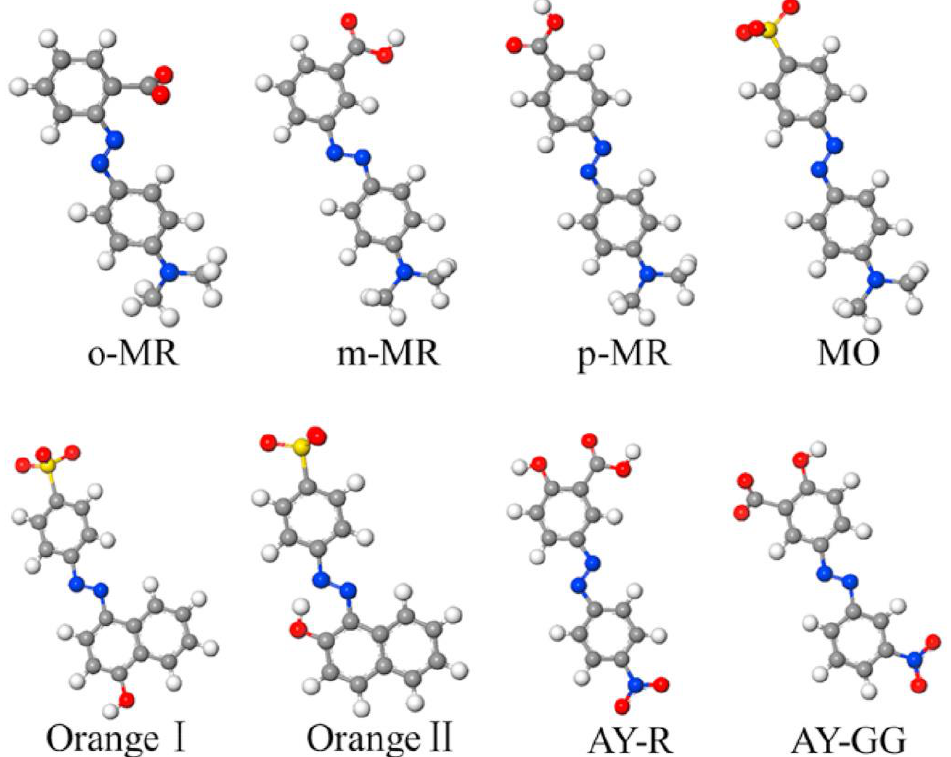
Figure 14. Molecular structure of several azo dyes (ortho-methyl red, meta-methyl red, para-methyl red, methyl orange, methyl orange I, methyl orange II, alizarin yellow R, and alizarin yellow GG). The gray, red, blue, yellow, and white balls represent carbon, oxygen, nitrogen, sulfur, and hydrogen atoms, respectively. Reprinted from ref. [205] with